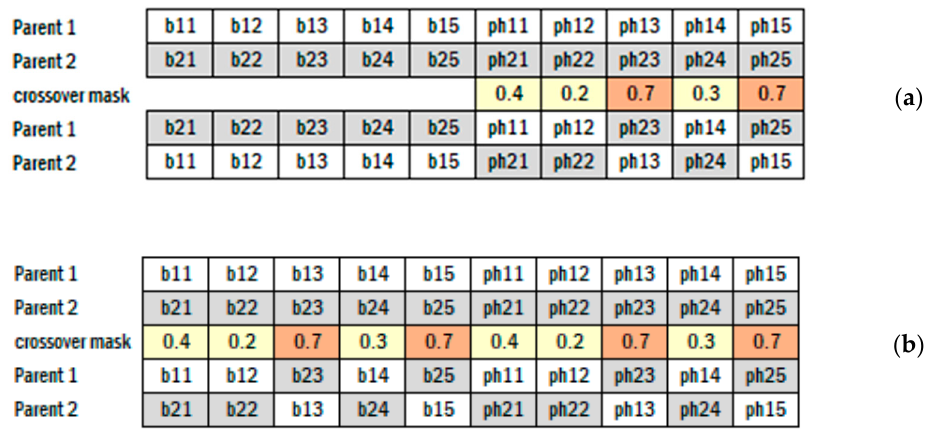
Figure 3. The uniform crossover procedure modified for the ESMRG algorithm: ( a ) Scenario 1; ( b ) ( b ) Scenarios 2 and Scenarios 2 and 3.